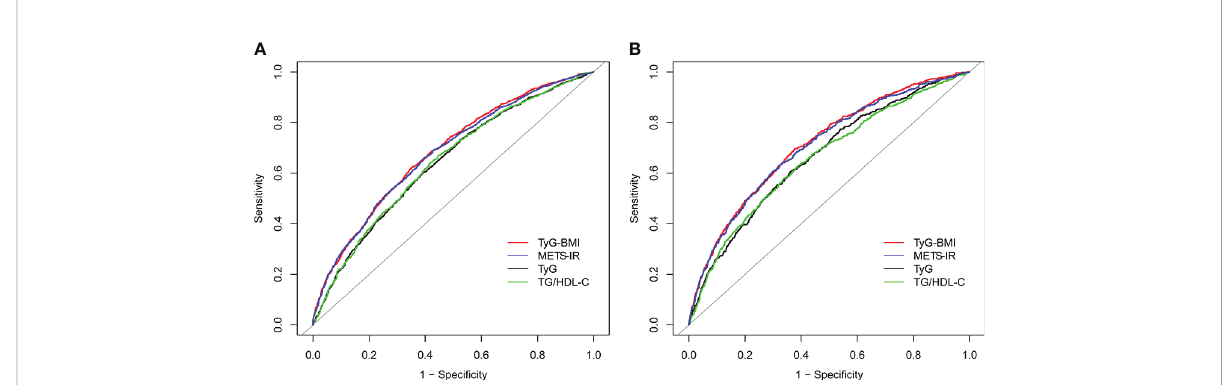
FIGURE 3 ROC for different IR surrogates to predict HU in (A) males; and (B) females. HU, hyperuricemia; TyG, triglyceride glucose; TyG-BMI, triglyceride glucose with body mass index; TG/HDL-C, the ratio of triglycerides divided by high-density lipoprotein cholesterol; METS-IR, metabolic score for insulin